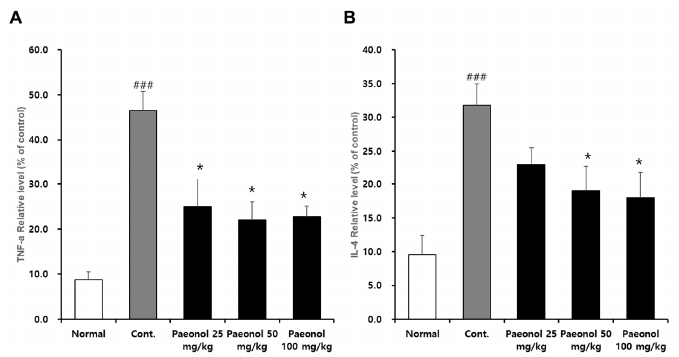
Figure 10. Effects of paeonol on TNF- α ( A ) and IL-4 ( B ) cytokine levels in a mouse model of linco- mycin-induced diarrhea. Paeonol was orally administered to lincomycin-induced diarrhea mice. Blood was collected and used for the cytokine measurements. The absorbance values were used to generate the graph plots. ### p < 0.001 vs. normal group; and * p < 0.01 vs. cont. group.